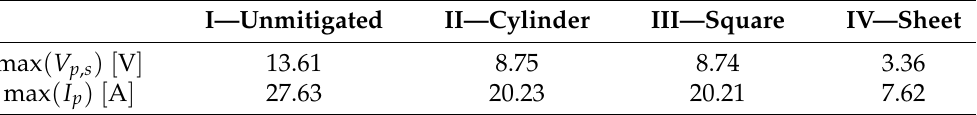
Table 2. Summary of maximum pipe-to-soil voltage and pipeline current for the four different described configurations.